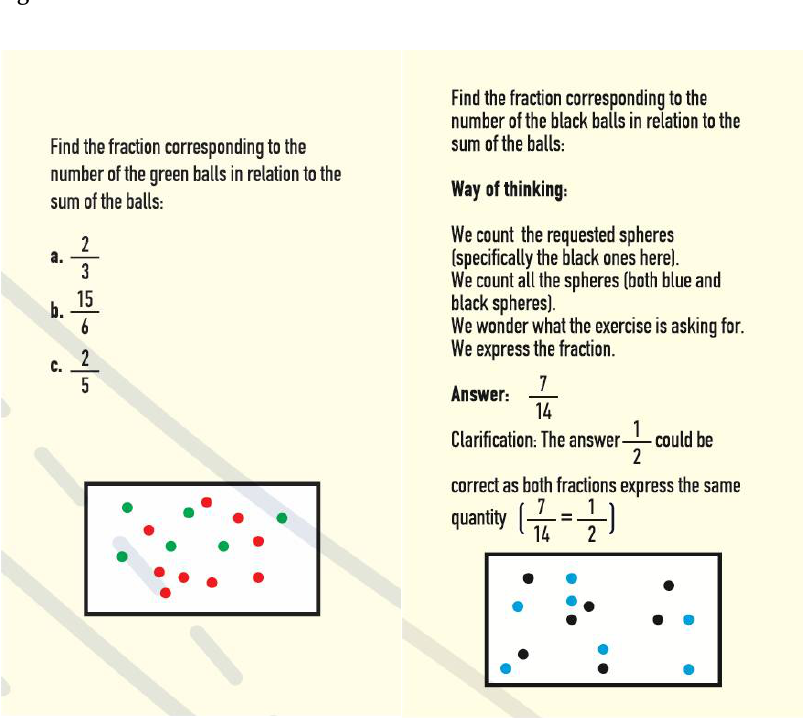
Figure 2. Two sides of a card of the game.